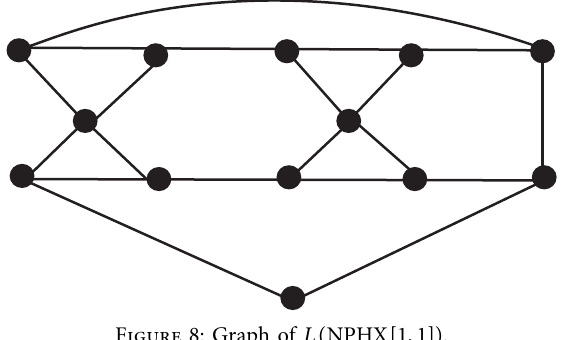
Figure 8: Graph of L ( NPHX [ 1 , 1 ]) .